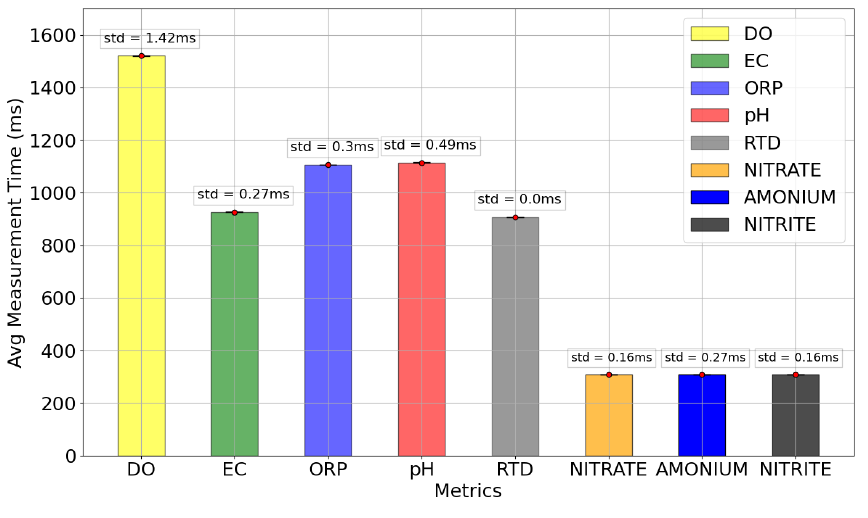
Figure 14. Time Measurements of WaterMon Sensors.